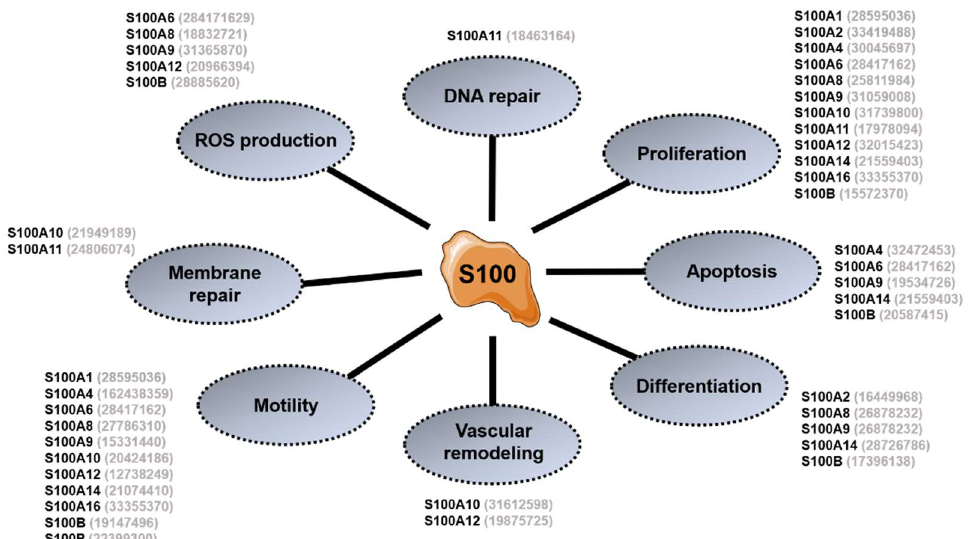
Figure 3. Schematic overview of the main cellular functions attributed to the activity of S100 proteins. Grey numbers in parentheses refer to the PMID of representative studies supporting the indicated function for S100 proteins.